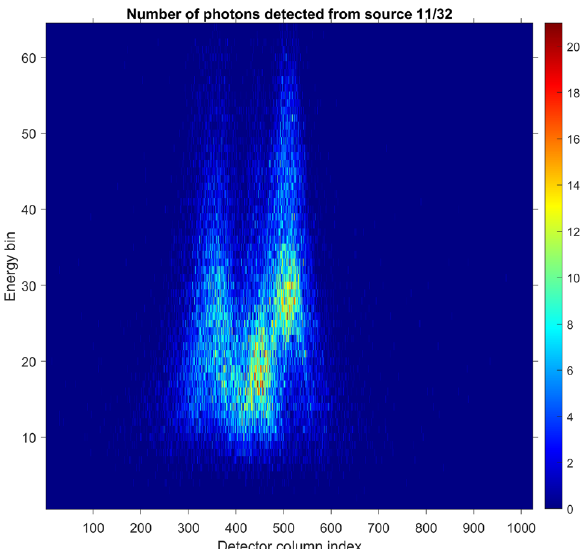
Figure 9. One slice of the deterministic forward simulation, with Poisson noise added as described in Eq. (1). In total there are approximately 44,000 photons in this detector snapshot, or about 1,100,000 photons for all 32 source positions.